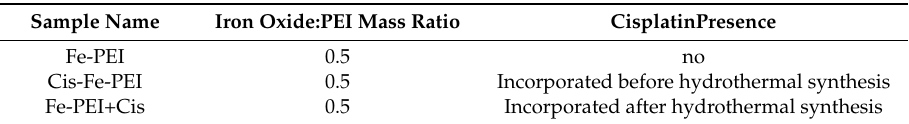
Table 1. Synthesis parameters for nanostructured hybrids based on iron